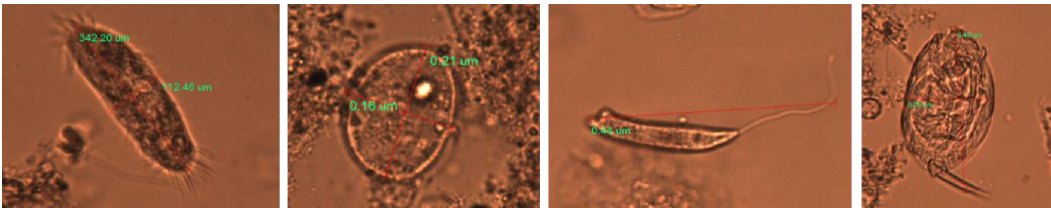
Figure 10. Microorganisms observed in the water purification test.